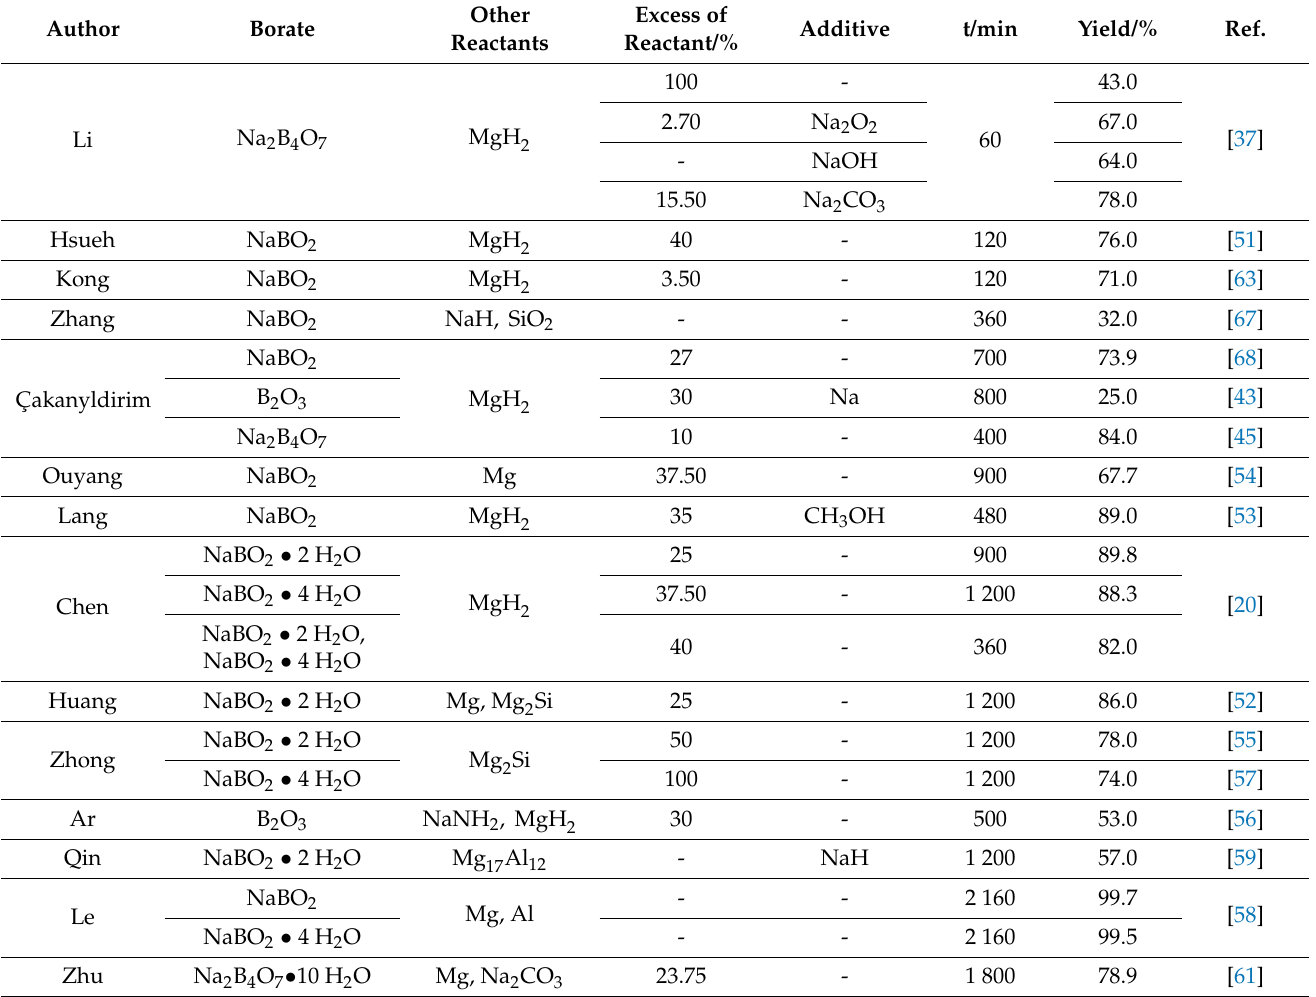
Table 2. Summary of mechano-chemical processes for NaBH 4